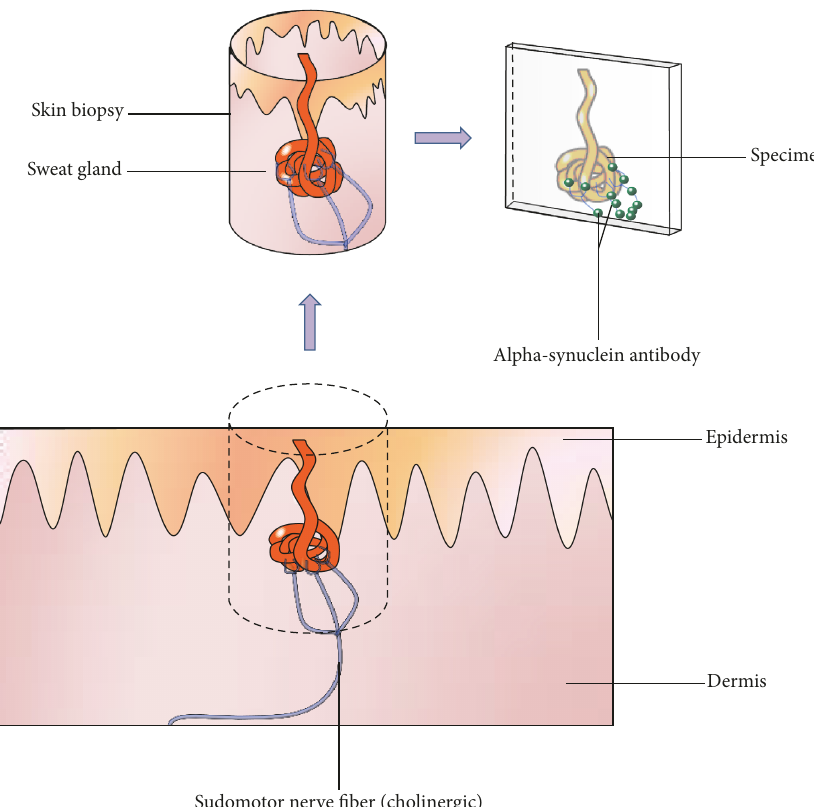
Figure 1: Obtaining a skin biopsy containing a sweat gland and staining of sudomotor nerve fibers. A punch biopsy is obtained and stained using immunohistochemical antibodies for 𝛼 -synuclein (e.g., anti-phosphorylated 𝛼 -synuclein antibody) and nerve fibers (anti-protein gene product9.5antibody).Additionalcostainingwiththecholinergicmarkervasoactiveintestinalpeptidecanbeperformedtospecificallyidentify 𝛼 -synuclein deposits in cholinergic sudomotor fibers. Figure designed by Dr. Siepmann and Dr.